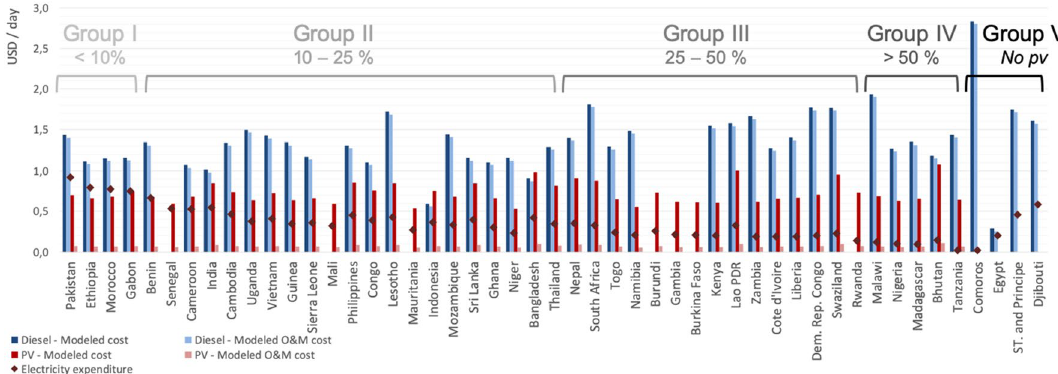
Figure 5. Modelled electricity generation costs—total and O&M—versus potential daily expenditure on electricity per poor household per day. These cost estimates are calculated under the adverse PV conditions scenario and clustered in five groups, according to the ratio between the potential daily expenditure on electricity and the modelled generation cost (total and O&M). Blue columns show average diesel-based electricity costs per country (O&M costs are presented in light blue), and red columns show average PV electricity generation costs (O&M costs are presented in light red). Rhombus sow the average potential daily expenditure on electricity per country. Group I clusters the countries where this expenditure is greater than the generation cost per day. Stated differently, in these countries electricity is more affordable among poor households. At the other extreme, in Group IV, electricity generation costs per day are at least 50% higher than the potential daily expenditure on electricity. In other words, in these countries poor populations face more difficulty in covering the cost of electricity. If the competing technology is cheaper across all locations within the country, the modelled cost (either PV or diesel) is not shown. Source: Authors’ compilation based on the